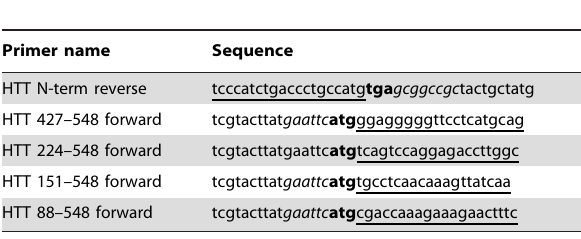
Table 1. Cloning primers used to generate the HTT 1–548 N- terminal deletion